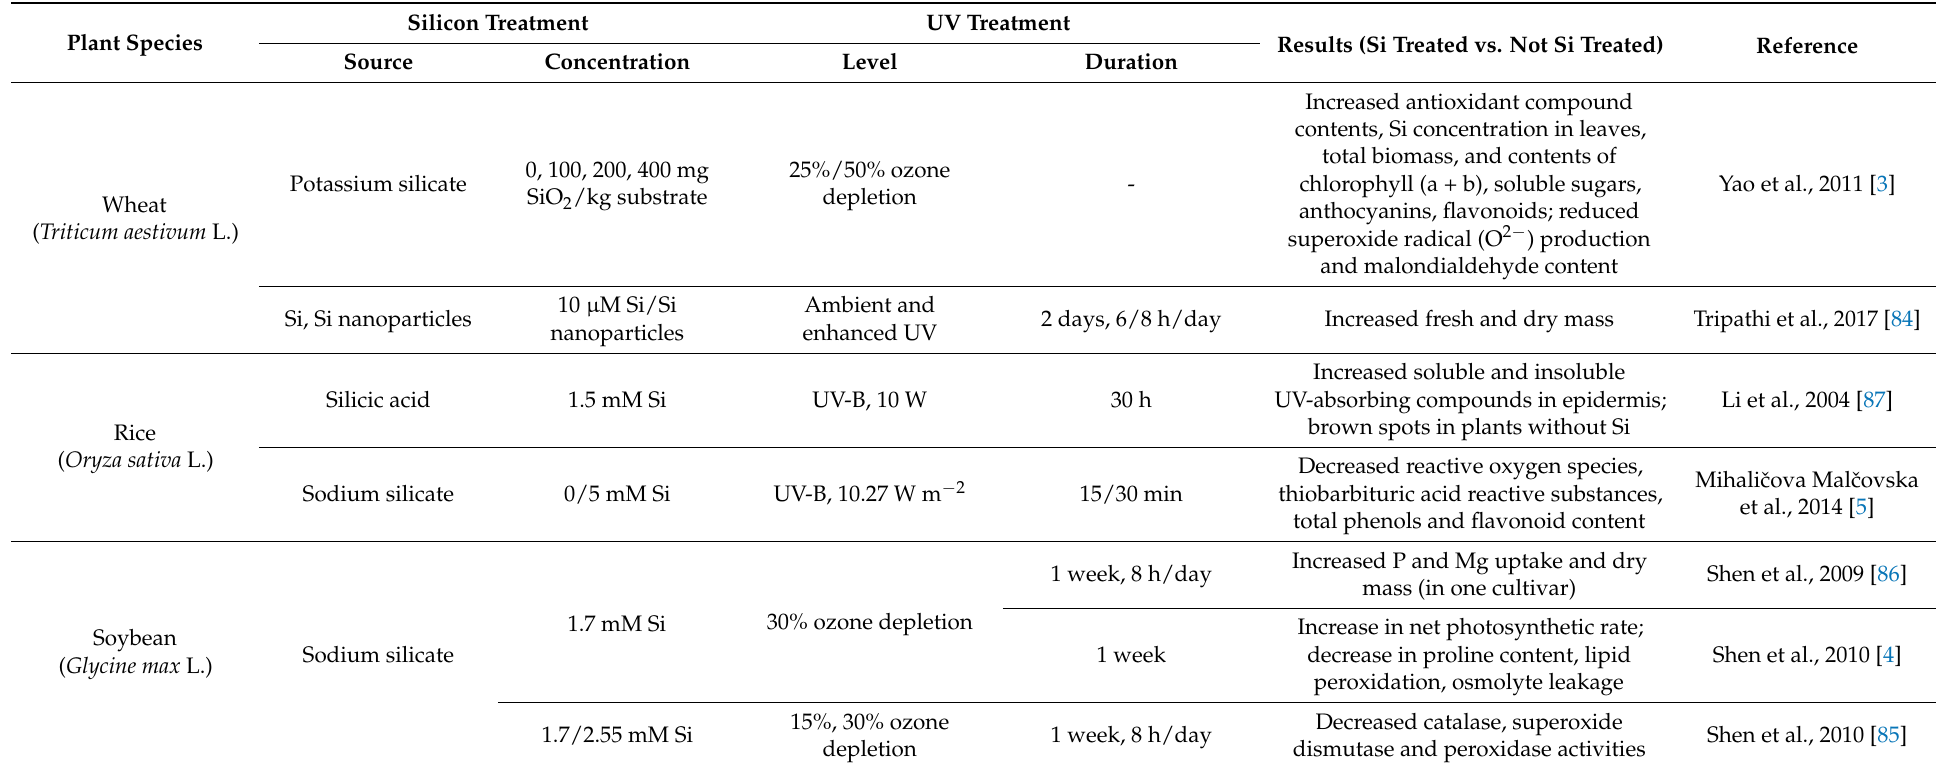
Table 2. Overview of studies on the relationships between UV-B radiation and silicon